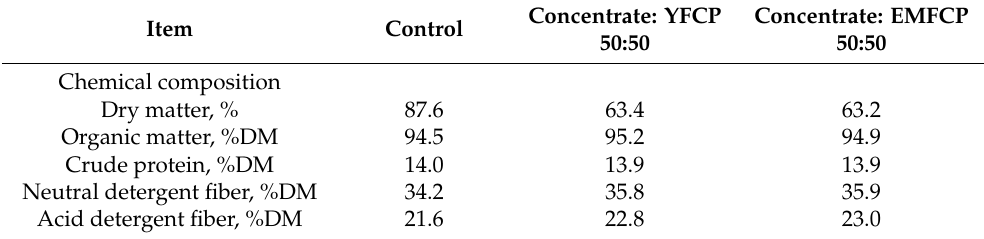
Table 2. Chemical compositions of the experimental